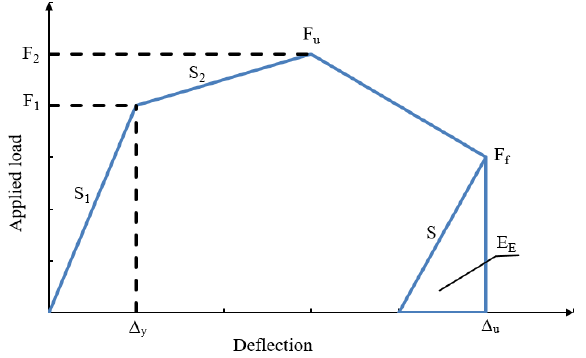
Figure 10. The ductility mode that used in this study [29].